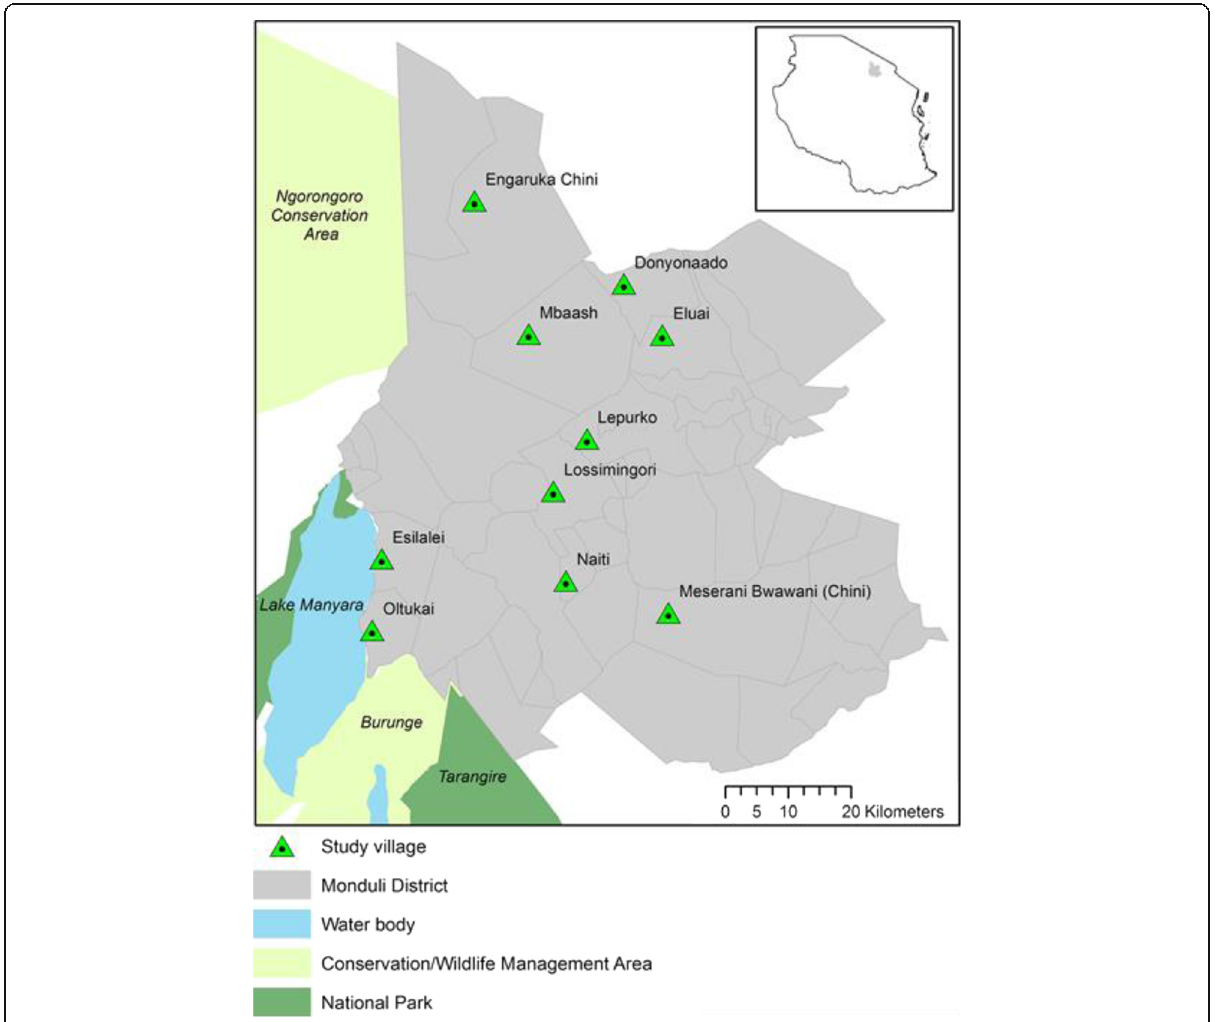
Figure 1 Map of Monduli District Northern Tanzania showing the ten study